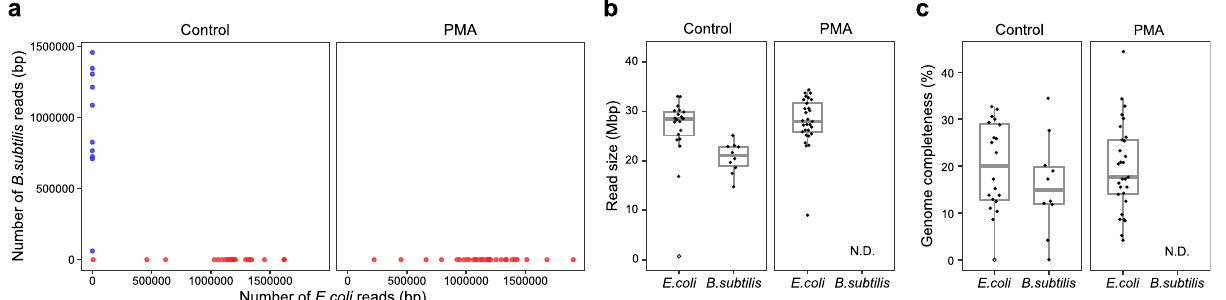
Figure 3. Verification of viable bacterial selectivity of single-cell sequencing via PMA-SAG-gel. PMA-SAG- gel sequenced a mixture of E. coli and heat-killed B. subtilis cells. ( a ) scatter plot shows the number of reads mapped to E. coli and B. subtilis genomes associated with each SAG (capsule). Red dots indicate droplets that were identified as E. coli from 16S rRNA data; blue dots indicate droplets that were identified as B. subtilis . ( b ) Size of raw sequence reads. ( c ) Genome completeness of SAGs. 32 SAGs were sequenced for each sample. PMA- heat- B. subtilis showed no fluorescent gel capsules, so we could not determine their sequencing states (N.D. not